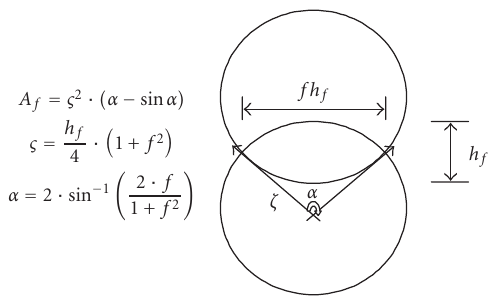
Figure 7: Construction and geometrical parameters of the tow sec- tion.